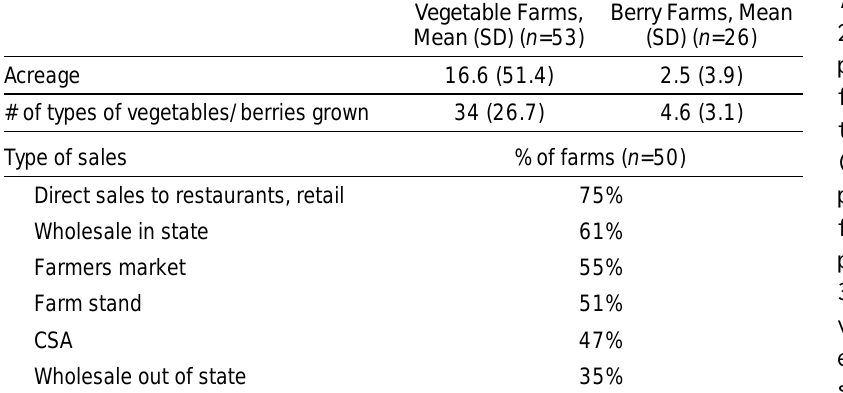
Table 2. Characteristics of Participating Farms, Including Acreage, Crops Grown, and Type of Sales, Vermont, 2016 Vegetable Farms,